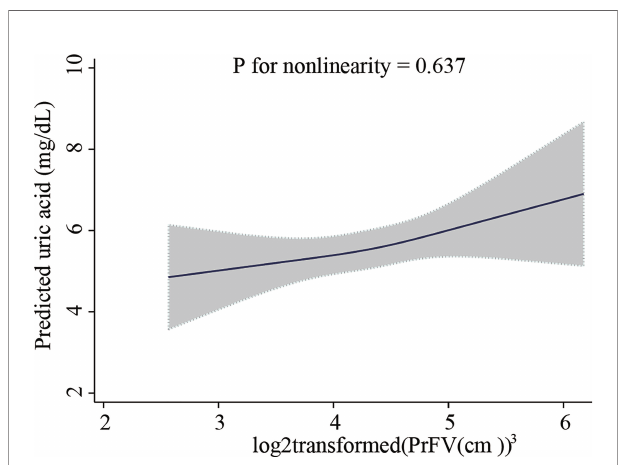
FIGURE 2 | Restricted cubic spline plot of the association between perirenal fat volume with serum uric acid level. Perirenal fat volume was log2-transformed. The analyzes were adjusted for age, sex, waist circumference, serum creatinine, and C-reactive protein. The solid line represents the predicted values of the serum uric acid level, and the gray area represents the 95% con fi dence